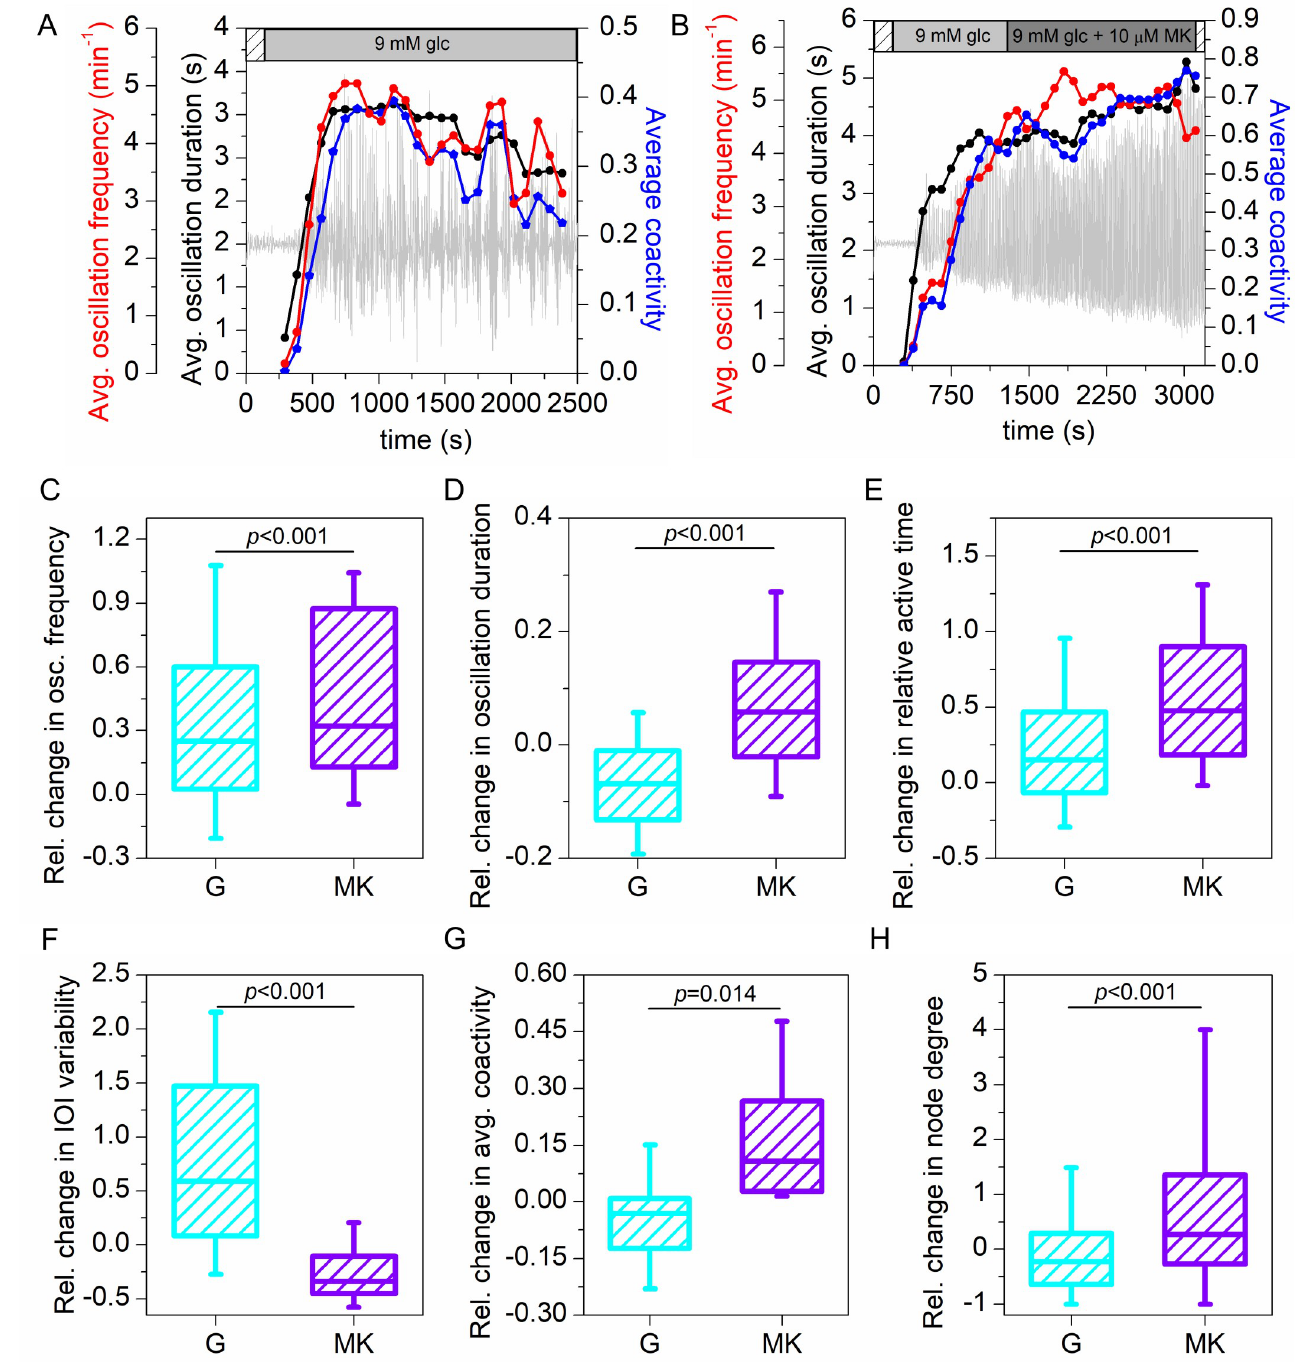
Fig 2. Quantifying beta cell activity in different protocols. Temporal evolution of the average oscillation frequency (red), average oscillation duration (black), and average coactivity of the cells (blue) for a recording in protocol G (A) and for a recording in protocol MK (B). Light grey curves show the average calcium signal. Panels (C)-(H) show the relative change in oscillation frequency, oscillation duration, relative active time, inter-oscillation interval variability, average coactivity, and node degree in the functional beta cell networks from interval 1 to interval 2 for all recordings in protocols G (cyan) and MK (violet). Whiskers indicate the 10th and 90th percentile, the box indicates the 25th and 75th percentile, and the horizontal line indicates the median value. Data were pooled from the following number of mice/cells/islets: 3/1373/10 (protocol G), 5/1731/12 (protocol MK). p –significance level. Statistical tests: Mann-Whitney Rank Sum Test (C, D, E, F, H) and Student’s t-test